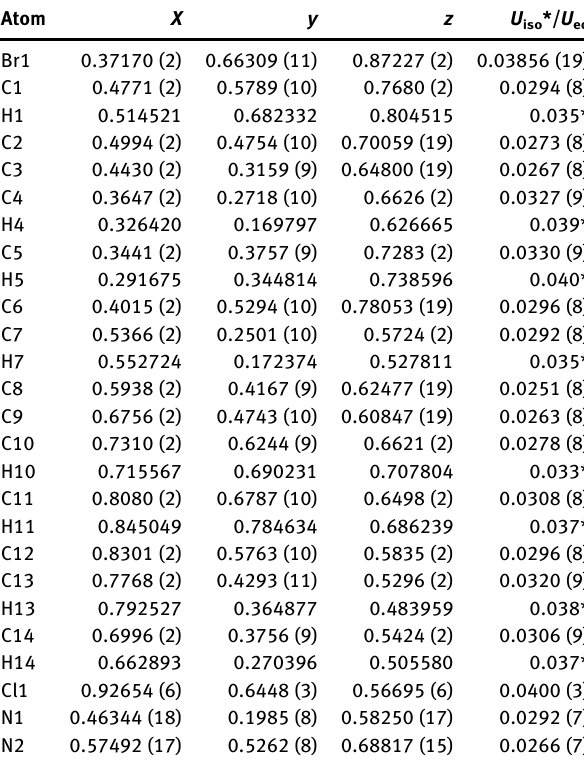
Table  : Fractional atomic coordinates and isotropic or equivalent isotropic displacement parameters (Å  ). Atom